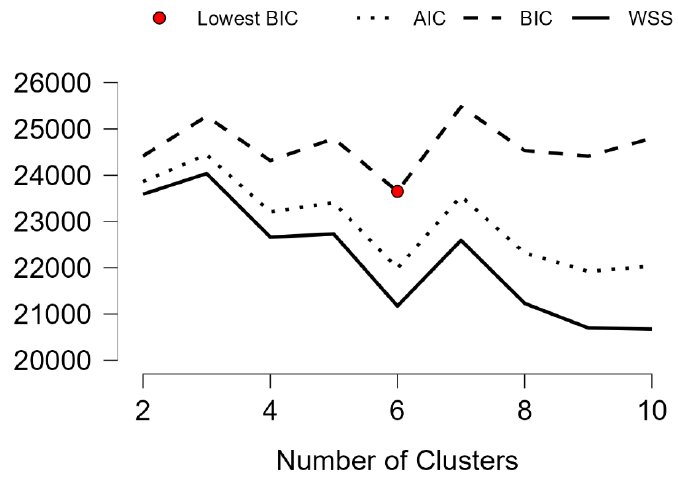
Figure 1. Elbow plot.